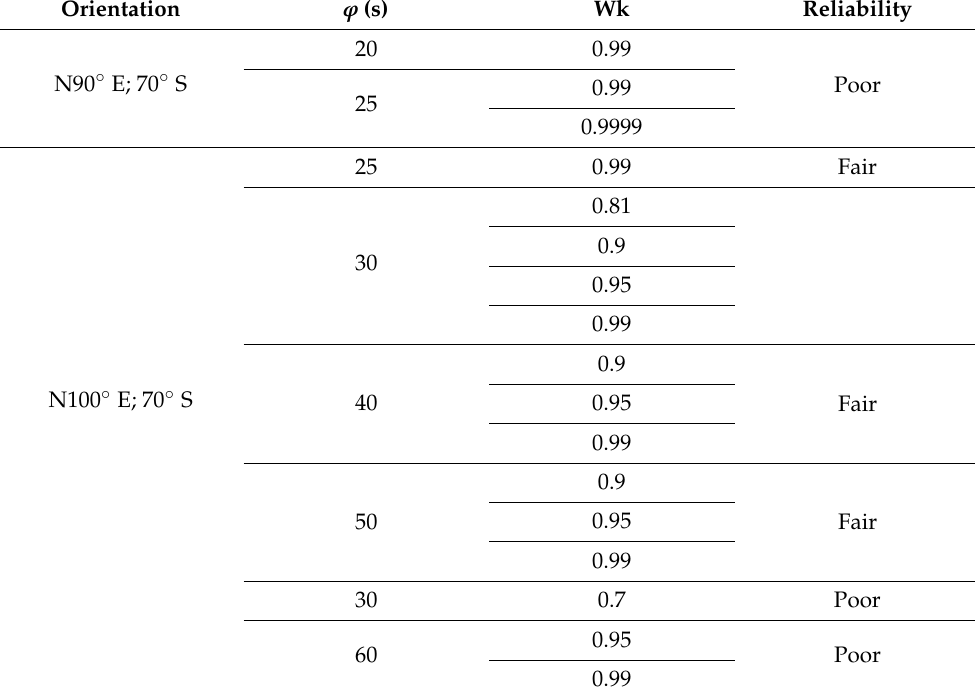
Table 1. List of the positive results after the application of the model and its